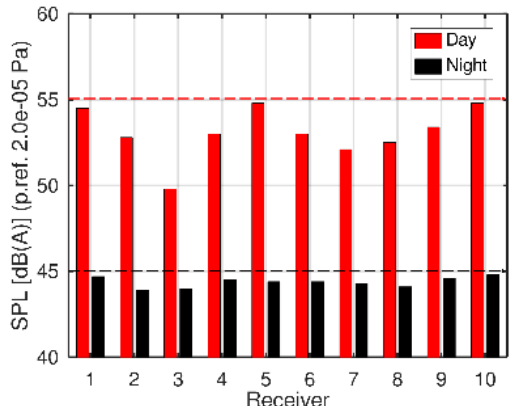
Figure 2. Equivalent continuous sound pressure level (LAeq) at the building’s façade before building the shopping centre (red bars and dotted line: day period, black bars and dotted line: night period).